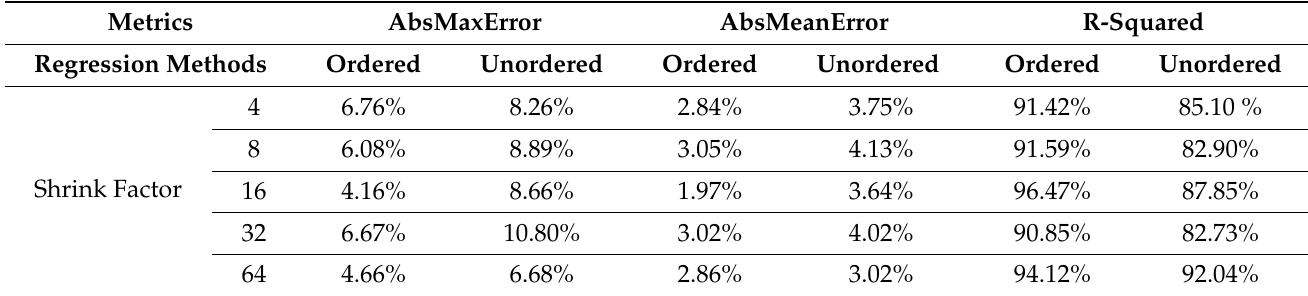
Table 4. Comparison between Ordered and Unordered Regression Models for Power Law Distribution.